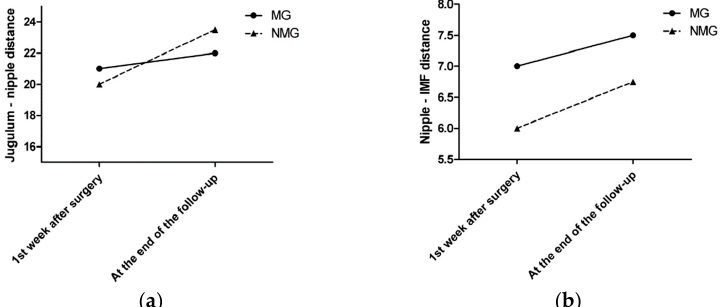
Figure 3. ( a ) The median sternal notch-to-nipple distance difference by time. ( b ) The median nipple-to-IMF distance difference by time. Every patient underwent control complex breast imaging (mammography as well as breast and axillary US) according to the ESMO guidelines for treatment and follow-up. Breast MRI was performed in 32 patients: 17 in the MG and 15 in the NMG. According to the control breast imaging examinations, the mesh did not disturb the clear visualization or oncological control of the underlying parenchyma (Figure 4a,b).